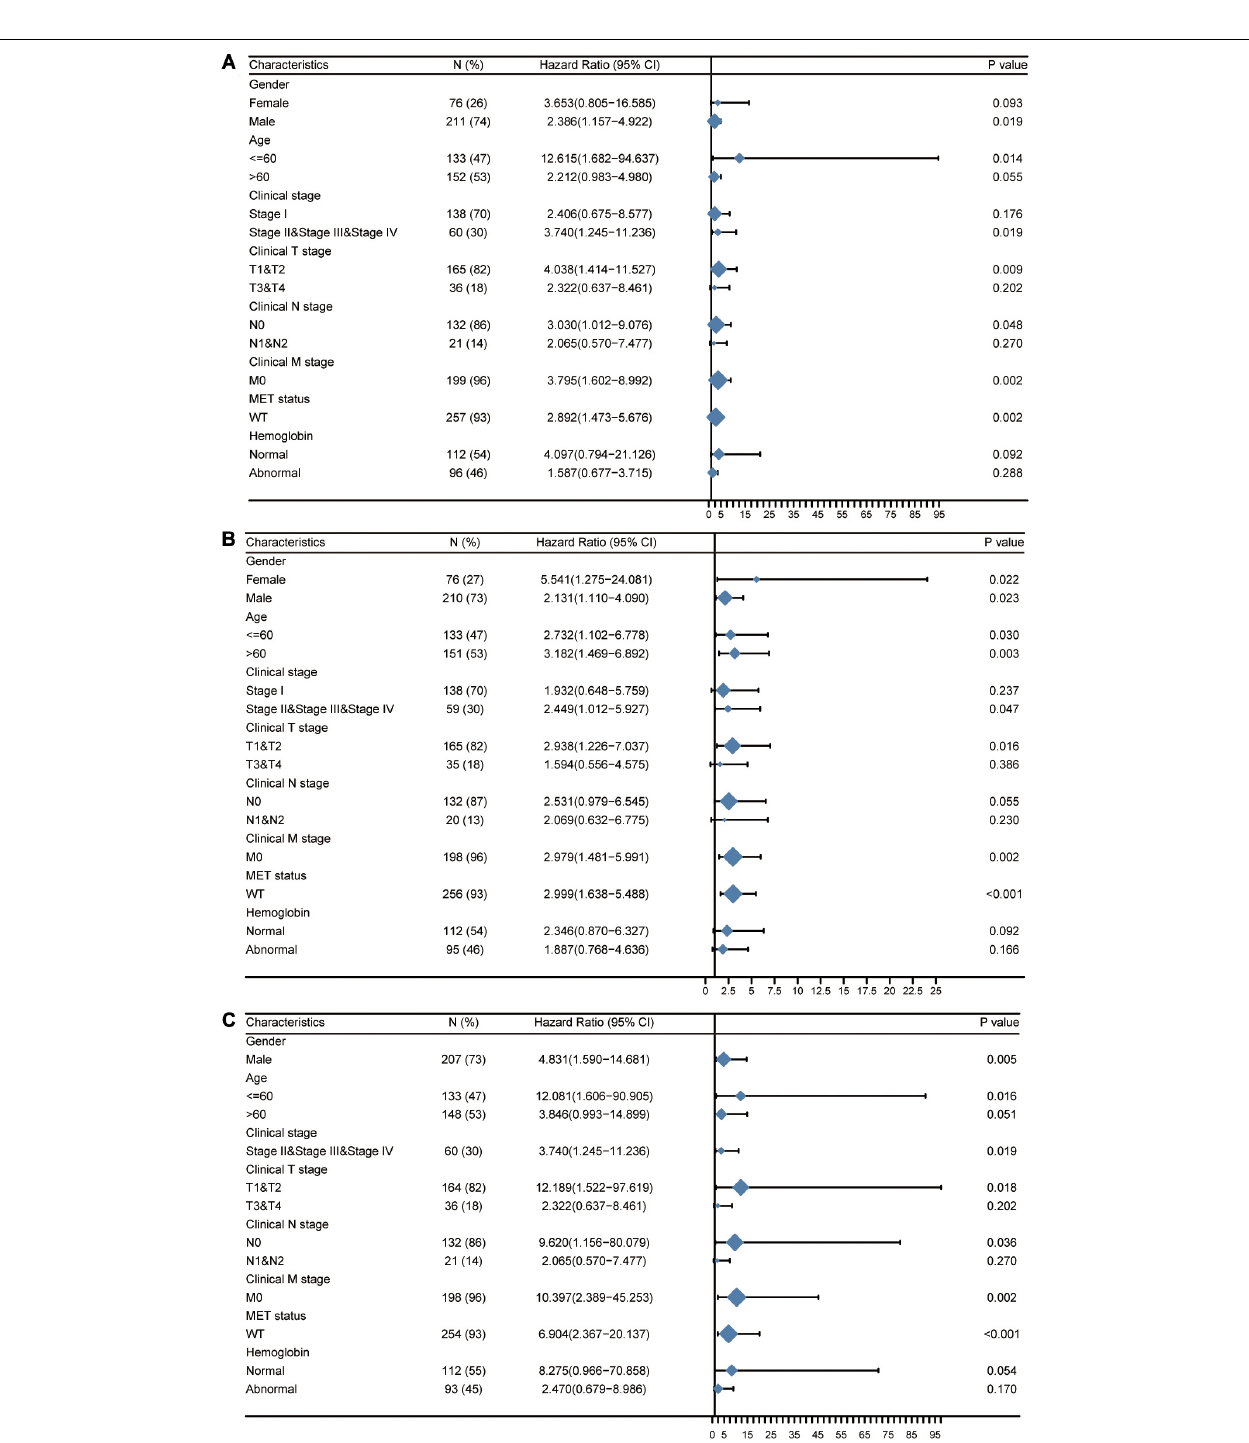
Frontiers in Genetics |